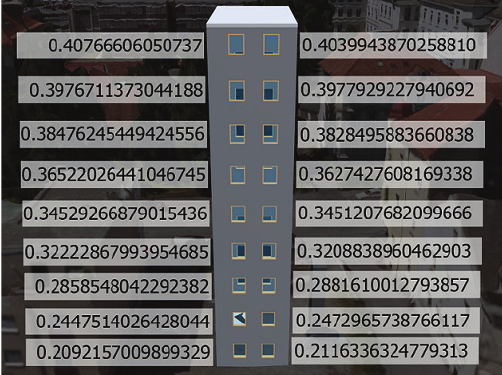
Fig ure 10. Windows view coeffi cients for all fl